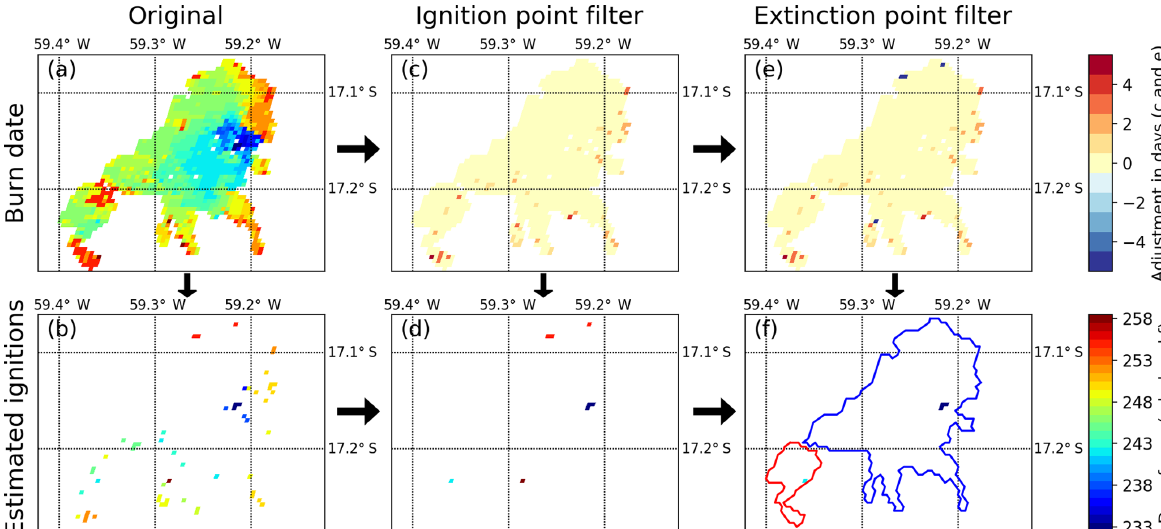
Figure 2. Algorithm example accounting for uncertainty in the “day of burn” and identifying individual fires within large clusters of adjacent burned pixels. (a) The original MCD64A1 Col. 6 day of burn for one burned patch in the Brazilian Cerrado (in the year 2015), and (b) local minima or “ignition points” identified within the original day-of-burn data layer. (c) Burn date adjustment based on the filter that removes local minima that do not progress continuously through time and space (positive adjustment), and (d) the corresponding estimate of ignition points based on the adjusted day-of-burn field. (e) Further burn date adjustment based on the removal of outliers along the edge of the fire (negative adjustment of extinction points), and (f) the final estimate of ignition locations and dates by the Global Fire Atlas, based on the combined adjustments shown in (e) . In (f) , the red and blue lines indicate the final fire perimeters.